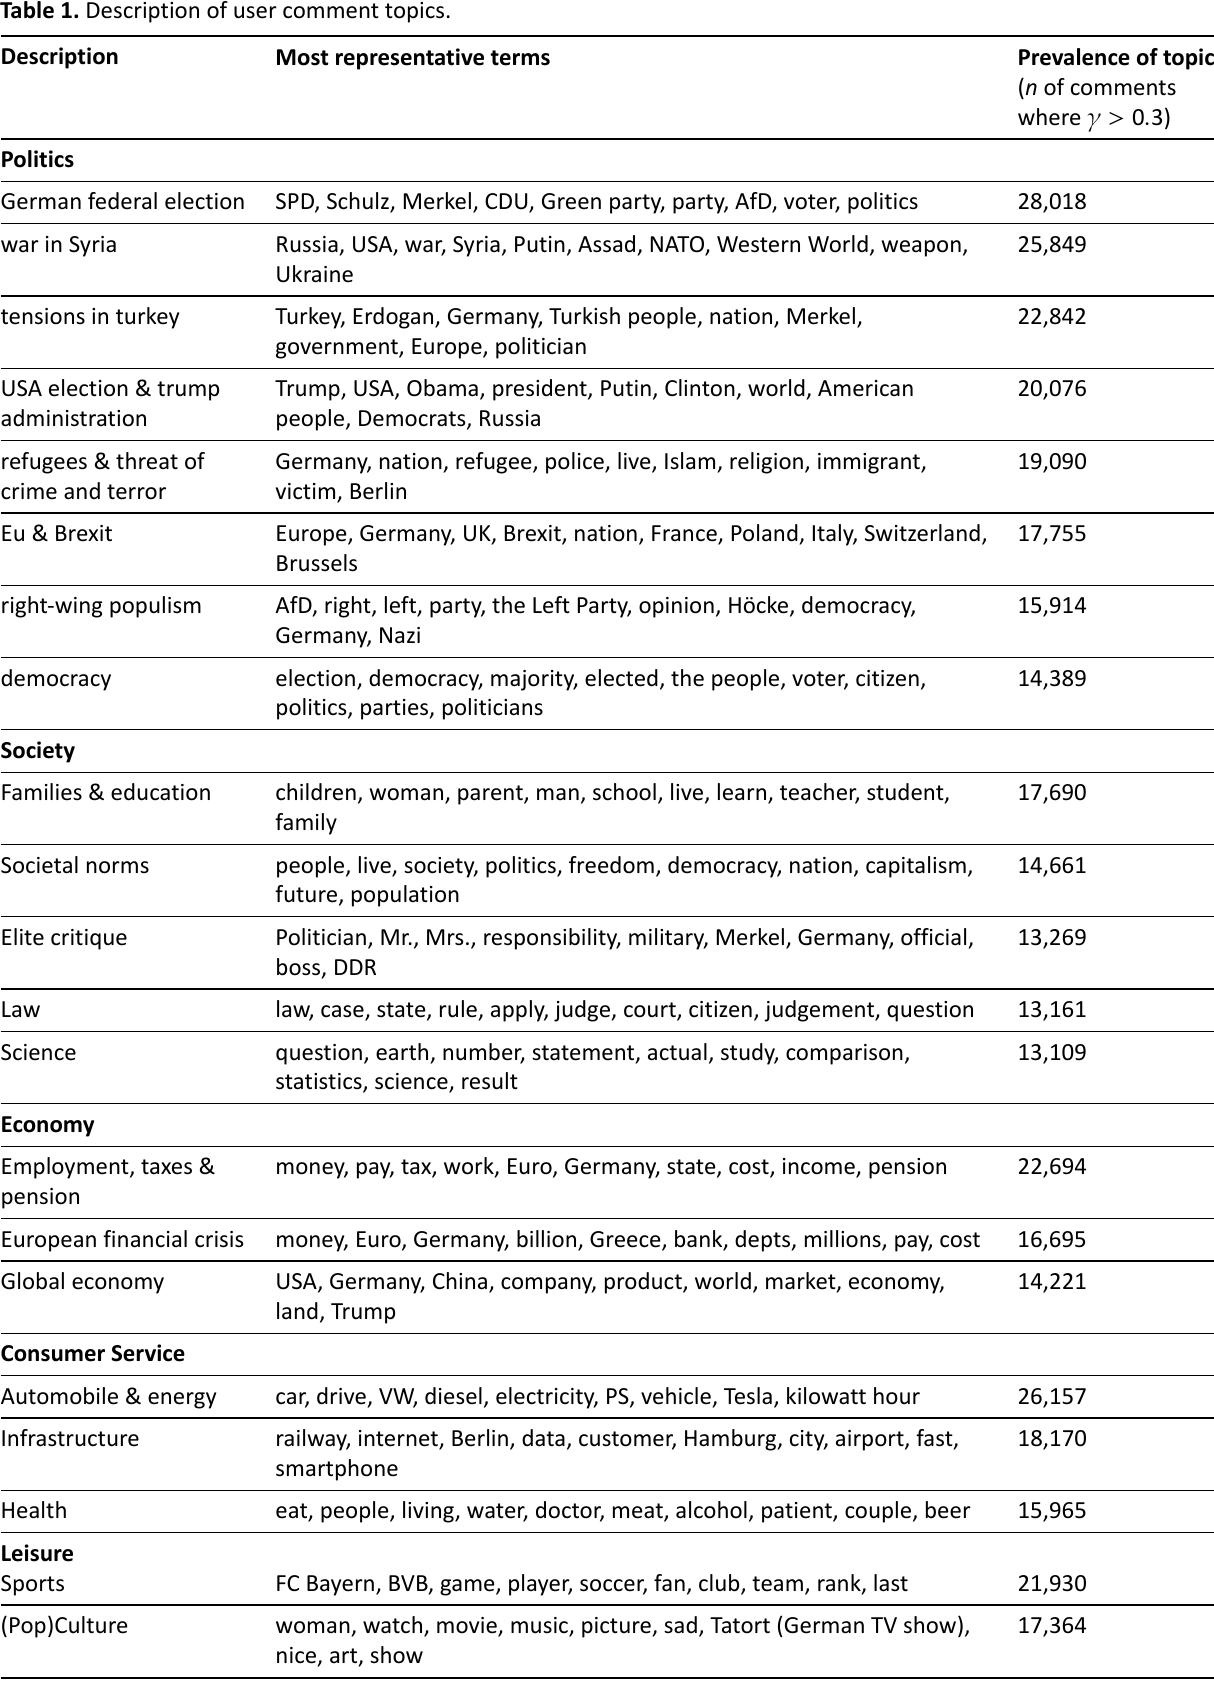
Table 1. Description of user comment